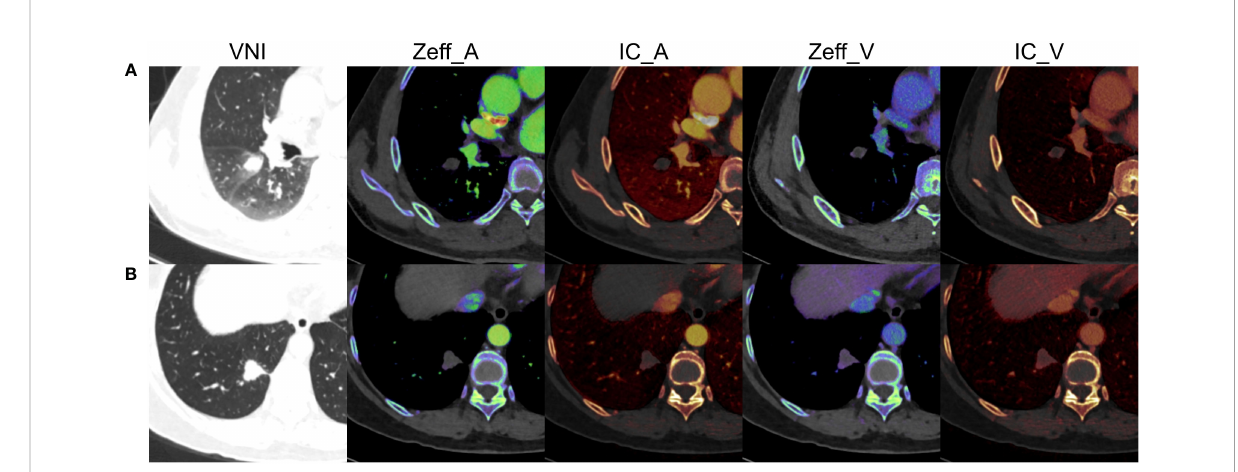
FIGURE 2 The representative dual-energy computed tomography images of solid pulmonary nodules. (A) A 49-year-old male with in fl ammation, diameter = 14.9 mm, volume = 1.949 cm 3 , Zeff_A = 7.57, IC_A = 0.10 mg/mL, NIC_A = 1.15%, Zeff_V = 7.80, IC_V = 0.50 mg/mL, NIC_V = 10.00%. (B) A 66-year-old female with adenocarcinomas, diameter = 18.8 mm, volume = 3.832 cm 3 , Zeff_A = 8.19, IC_A = 1.30 mg/mL, NIC_A = 10.92%, Zeff_V = 8.33, IC_V = 1.70 mg/mL, NIC_V = 27.42%. VNI, virtual non-enhanced images; Zeff_A, effective atomic number in arterial phase; IC_A, iodine concentration in arterial phase; NIC_A, normalized iodine concentration in arterial phase; Zeff_V, effective atomic number in venous phase; IC_V, iodine concentration in venous phase; NIC_V, normalized iodine concentration in venous